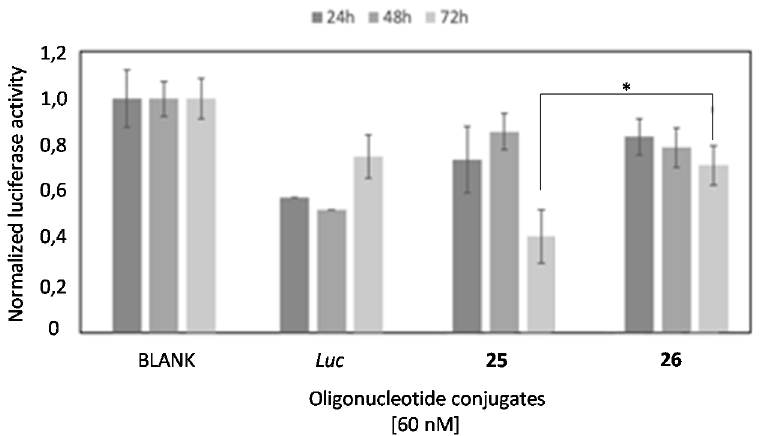
Figure 11. Gene transfection studies targeting Renilla luciferase mRNA without using transfecting reagents involving antisense G-rich oligonucleotide 25 and two control oligonucleotides such as the T-rich 26 and the luc -sequence (ASO) at 60 nM. Data were means ± SD of three to six independent experiments. A regular two-way ANOVA variance analysis combined with Bonferroni post-test for multiple comparisons was evaluated (* p < 0.05).